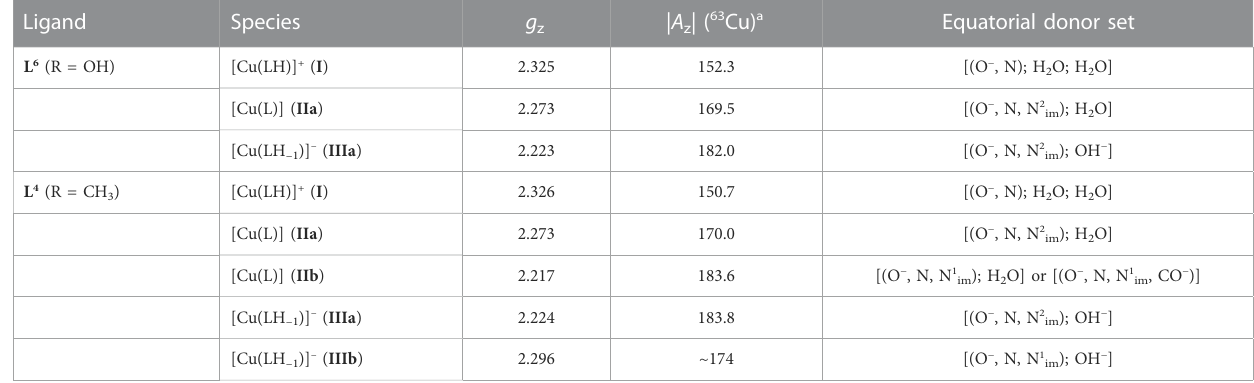
TABLE 4 Experimental spin Hamiltonian parameters for Cu(II) complexes formed by L 6 and L 4 .